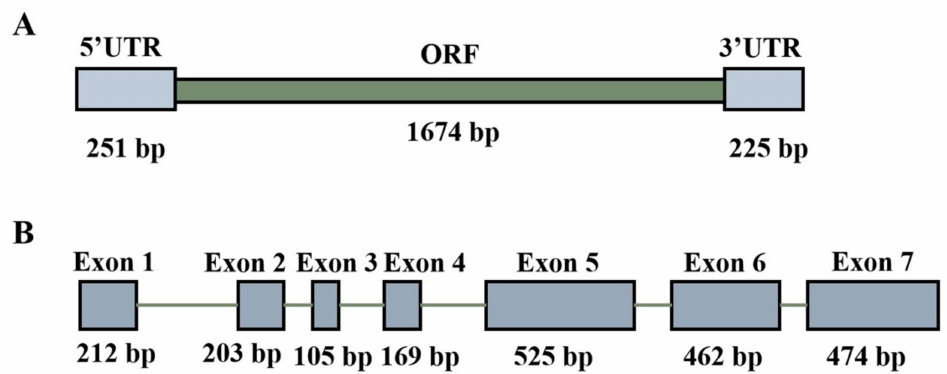
Figure 1. Gene structure analyses for Triticum aestivum L. Tapetum Degeneration Retardation-Like ( TaTDRL) . ( A ) Schematic representation of the corresponding cDNA structure. The 5 (cid:48) untranslated region (UTR) and 3 (cid:48) UTR, and the complete coding sequences (CDSs) are indicated by blue and green boxes, respectively. ( B ) Genomic organization of TaTDRL . Blue boxes indicate exons encoding amino acids and green lines indicate introns. Numbers represent the lengths of each region in base